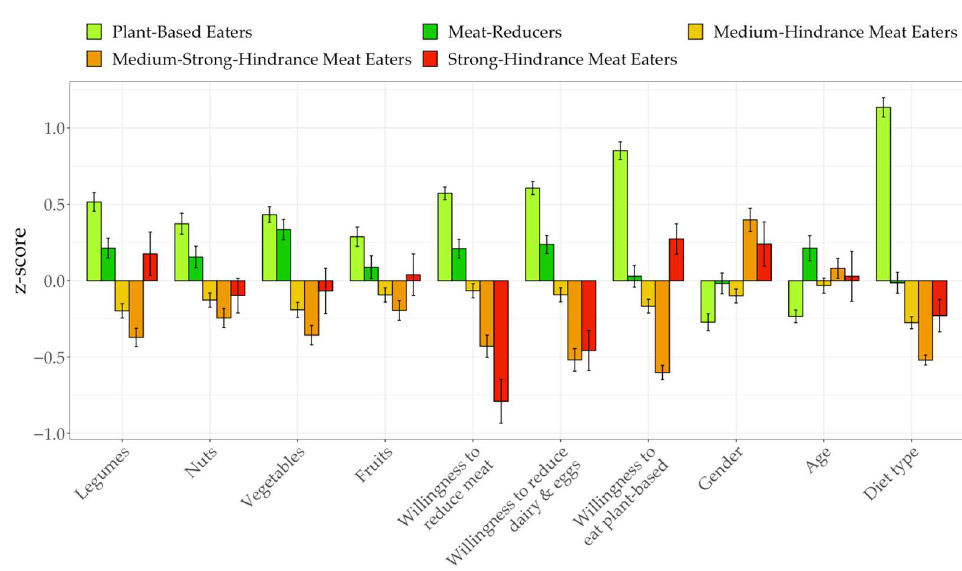
Figure 2. Means of outcome variables between profiles (continued)